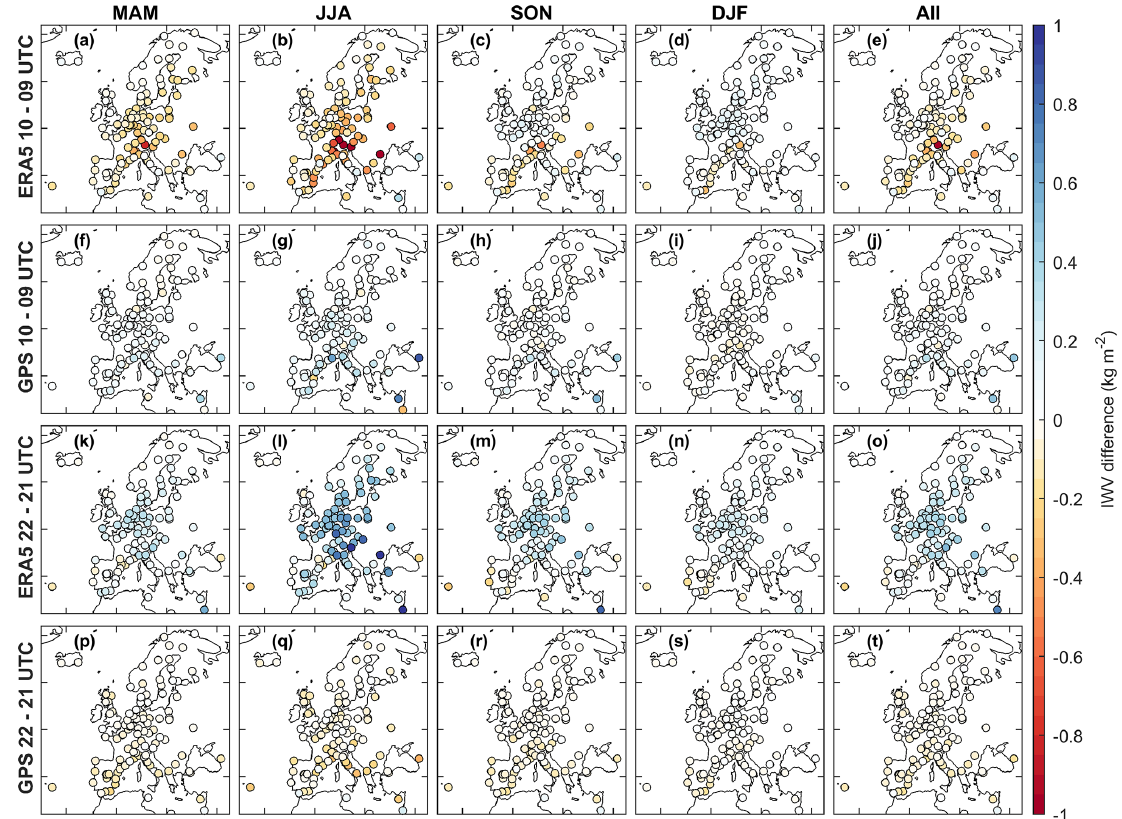
Figure 10. Seasonal-averaged and all-time-averaged IWV shifts in the GPS and ERA5 diurnal cycles from 09:00 to 10:00UTC and from 21:00 to 22:00UTC.